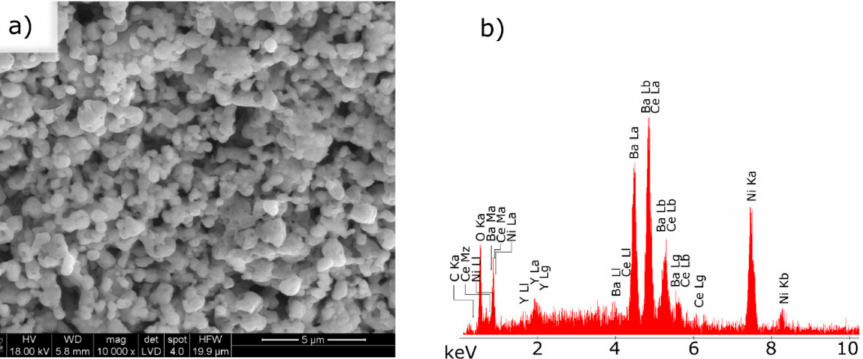
Figure 10. ( a ) Evolution of microstructure in the sintered NiO–5CBCY sample resulting from the reduction of NiO to Ni and thermal treatment at 700 ◦ C for 2 h in 10 vol.% H 2 in Ar ( b ) EDX spectra of the reduced Ni–5CBCY